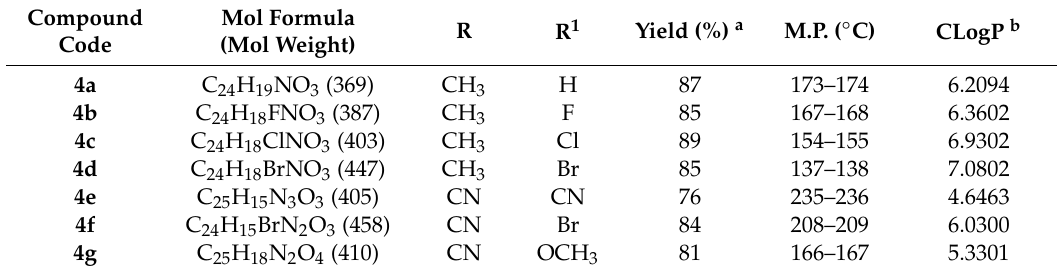
Physicochemical characteristics of methyl 3-(substituted benzoyl)-7-substituted-2-